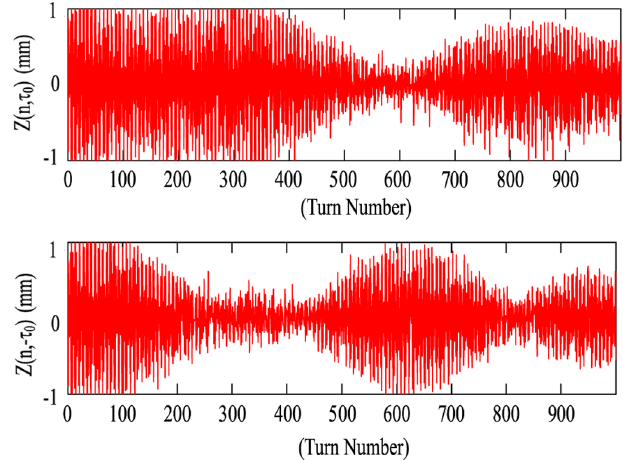
5. (Color) Plot of the envelope of Z (cid:3) n; (cid:1) (cid:4) from Eq. (12). After 1 mm kick with 0.4 ns longitudinal bunch slices of head (solid trace) and the tail (dotted) each 4 nsecs ( (cid:1) from the bucket center. Chromaticity is set to be (cid:4) (cid:5) 4 : 0 , (cid:4) 0 (cid:5) (cid:5) 3 nsecs 1500 , and (cid:8) (cid:1)